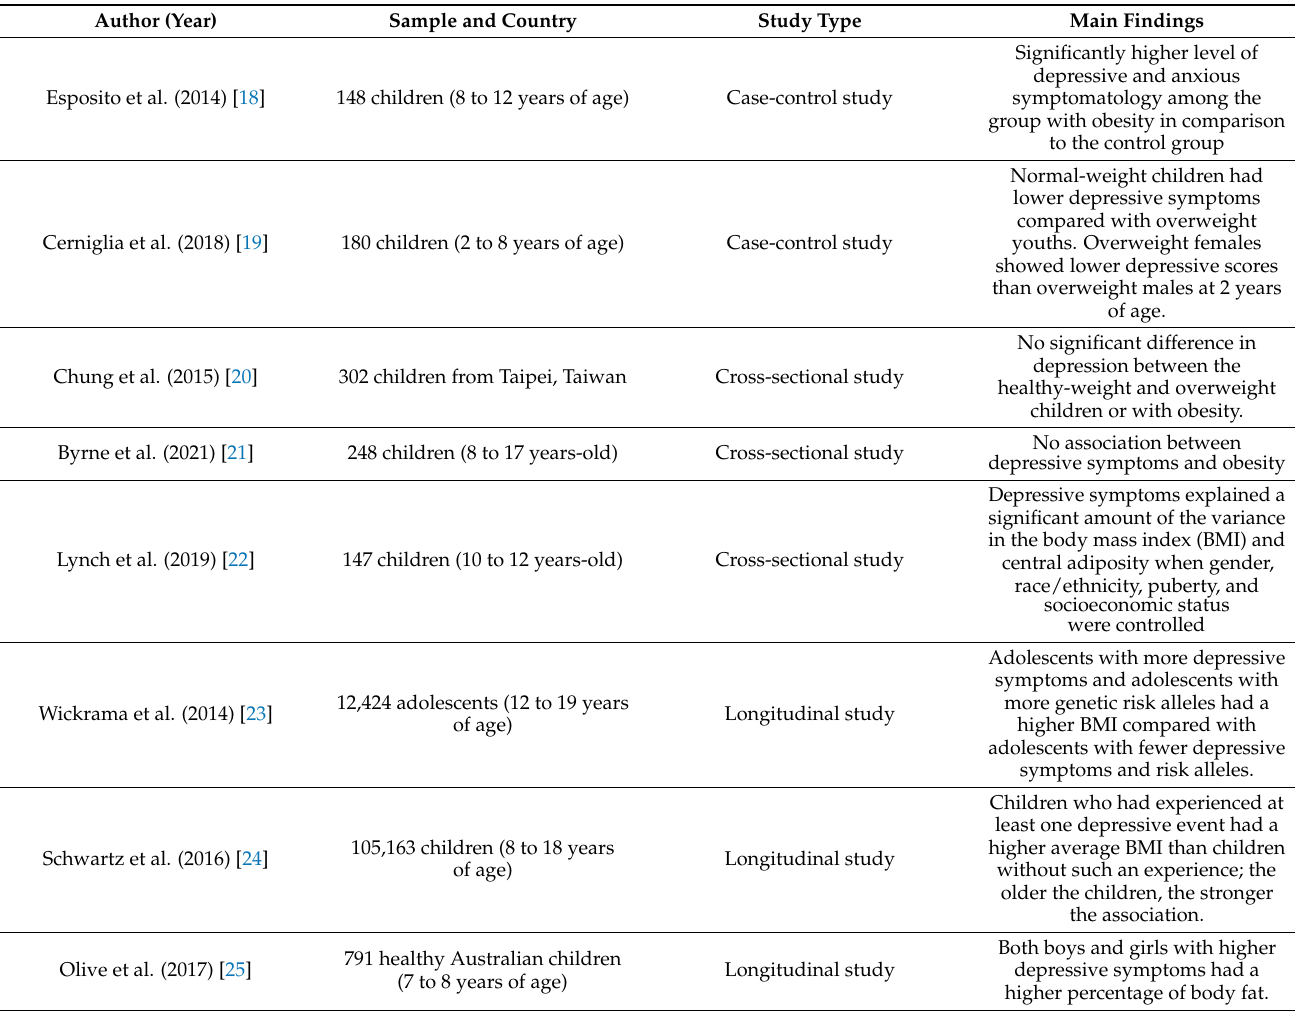
Table 2. Characteristics of studies that evaluated the association between depression and childhood